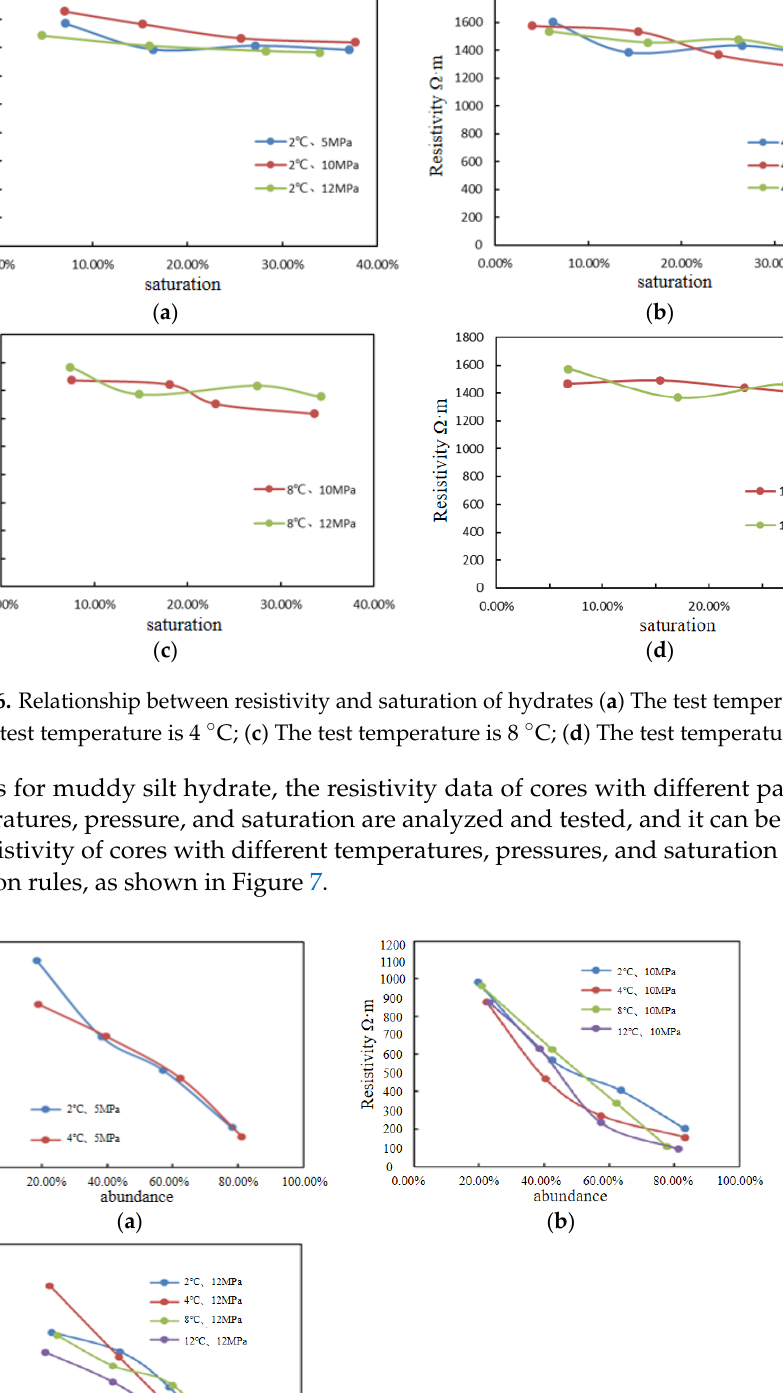
Figure 7. Relationship between the resistivity and saturation of hydrates ( a ) The test pressure is 5 MPa; ( b ) The test pressure is 10 MPa; ( c ) The test pressure is 12 MPa.